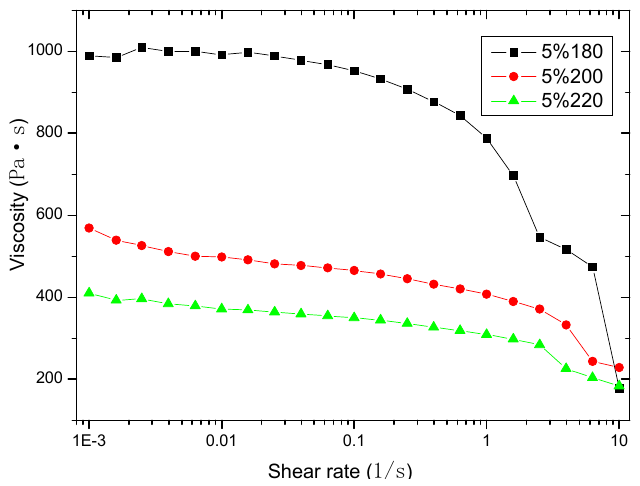
Figure 2. Variation of apparent viscosity of PP. matrix (5%) with shear